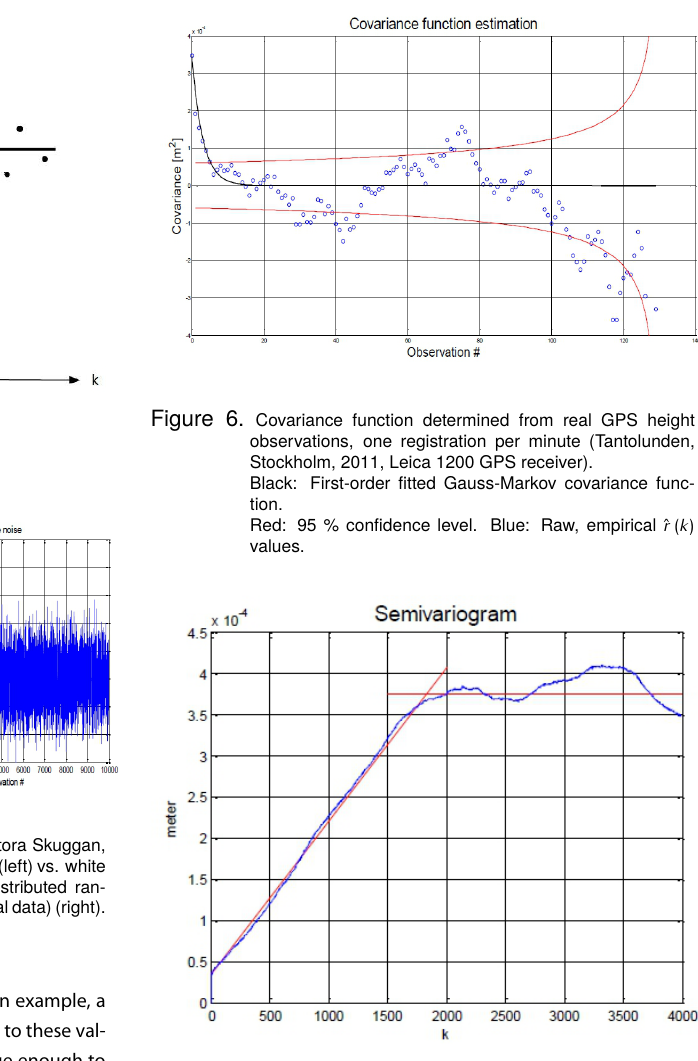
Figure 7. The estimation of sill and range for real GPS height ob- servations (Stora Skuggan, Stockholm, 2011, Leica